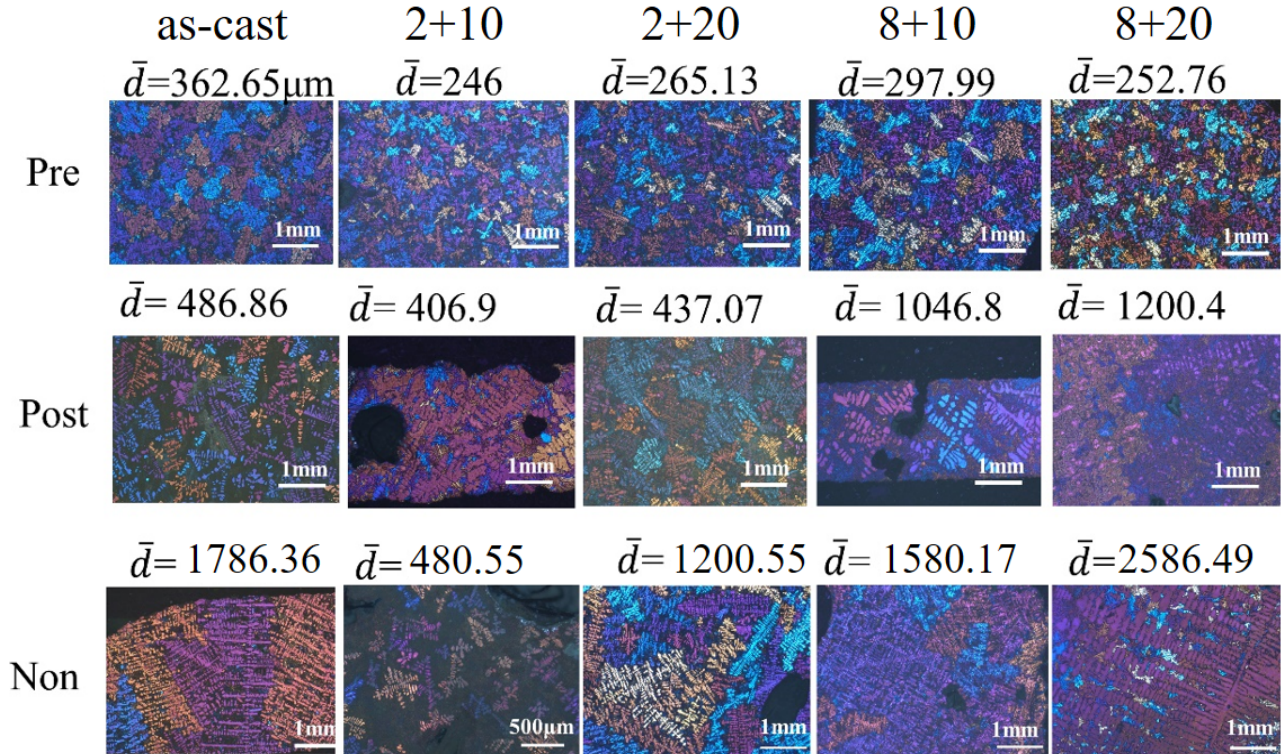
Figure 8. Dendrite structure and average grain diameter ( μ m) of the “pre-refinement”, “post-refinement”, and “non-refinement” as-cast and various heat-treated samples.